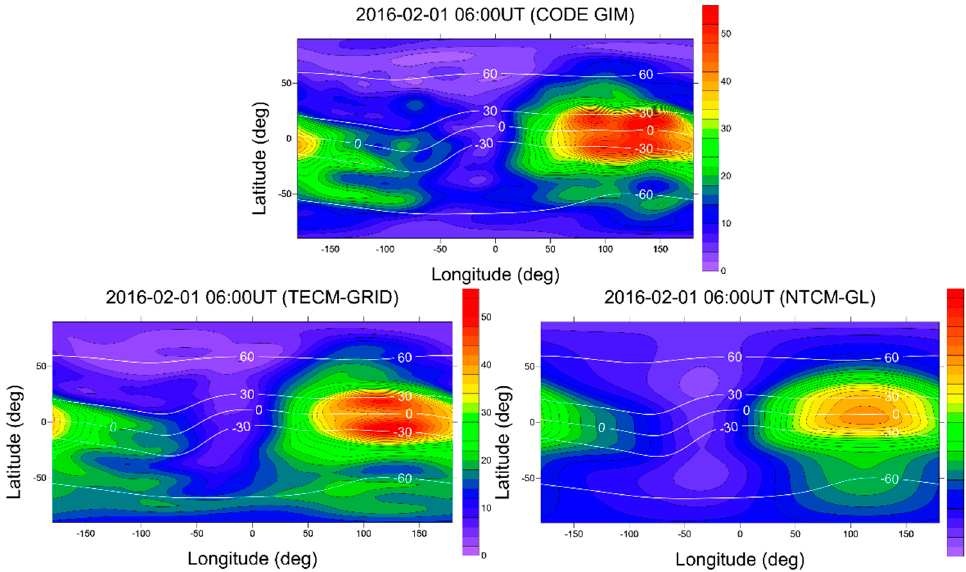
Figure 8. Comparison of TECM-GRID and NTCM-GL with the CODE GIM (1 February 2016).